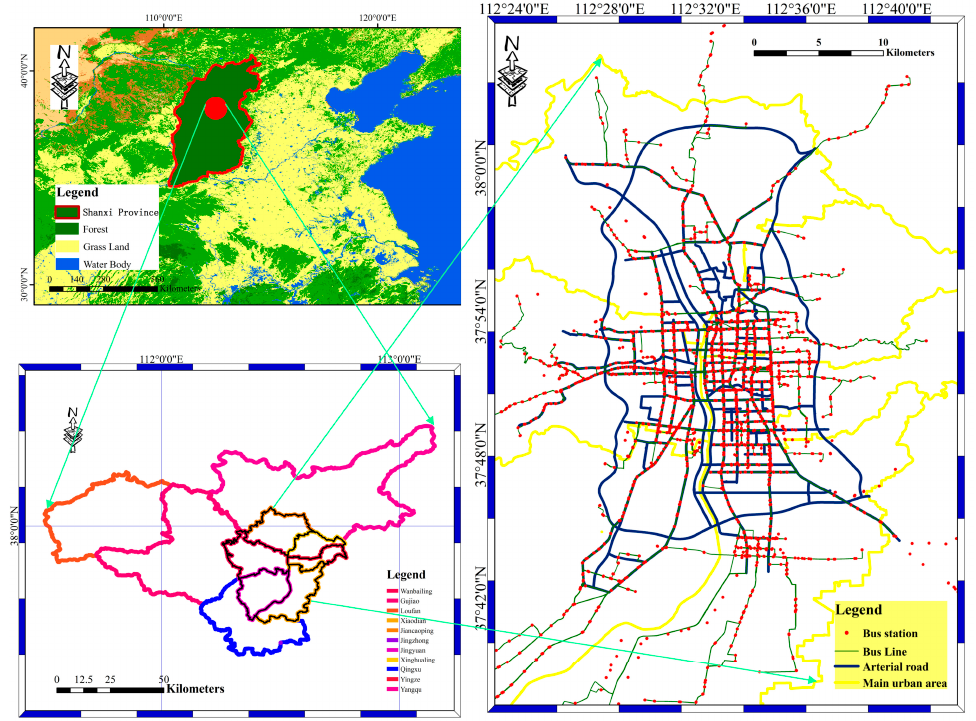
Figure 4. Spatial distributions of bus stations, bus lines and arterial roads in Taiyuan, Shanxi Province, China.